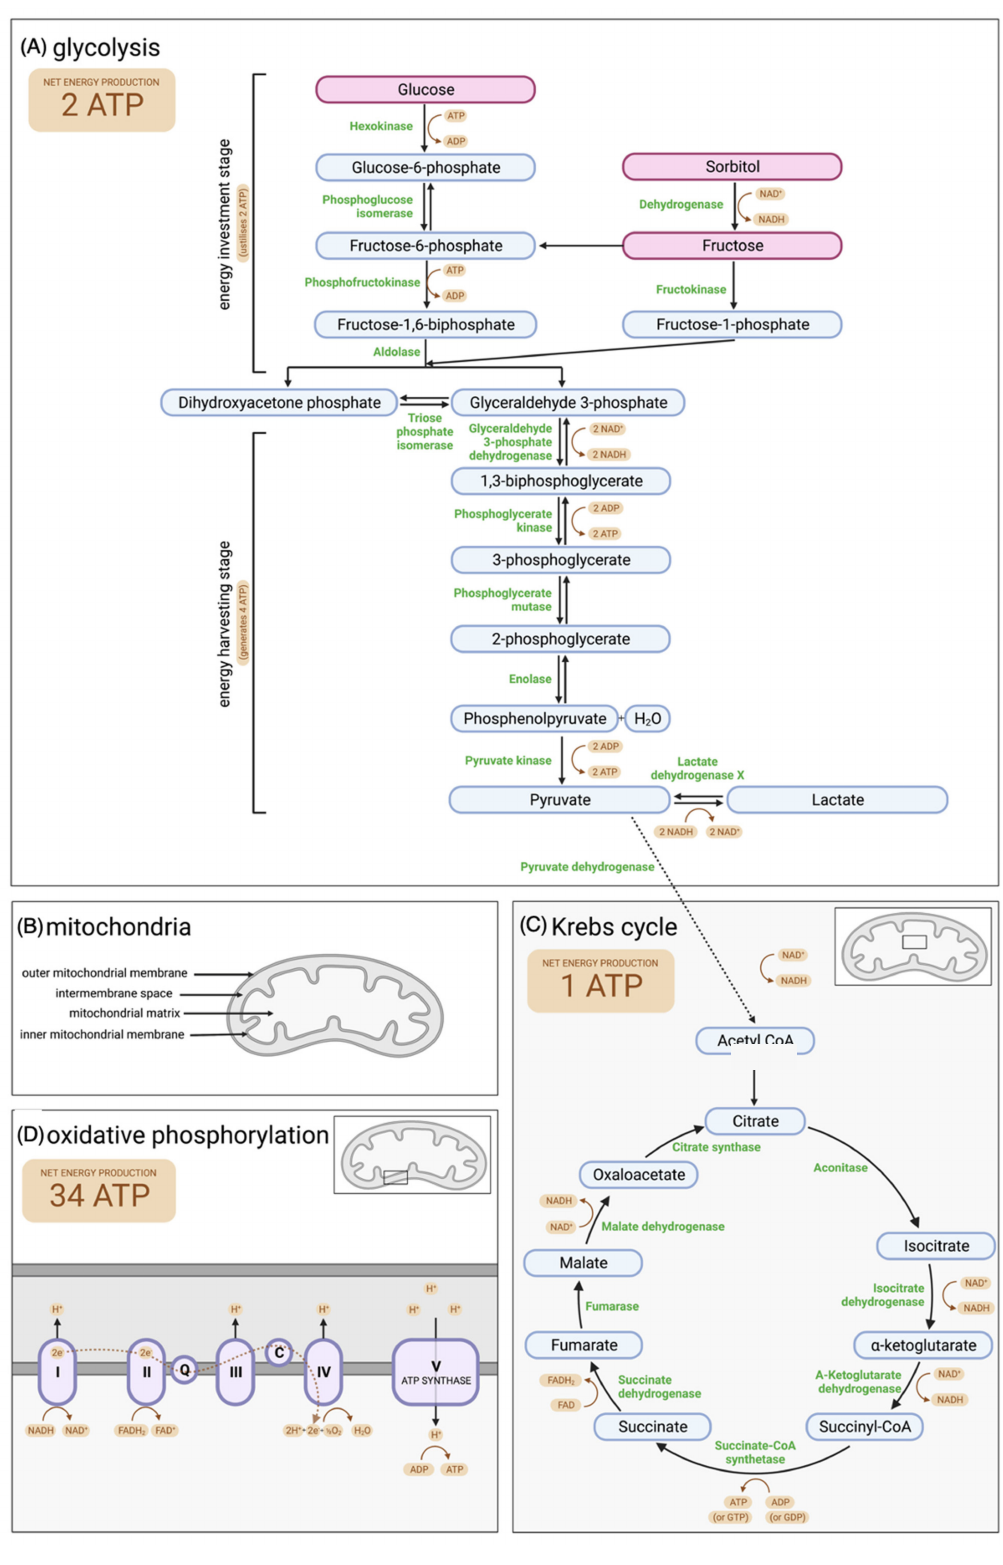
Figure 3. ( A ) Glycolysis. Occurs in the principal piece of spermatozoa. During glycolysis glucose, fructose or sorbitol is converted into pyruvate with a net gain of 2 adenosine triphosphate (ATP) molecules. Each step of glycolysis is catalysed by sperm-specific isoenzymes found in the principal piece, shown in green [42]. Glycolysis is broken into two phases: the energy investment stage and